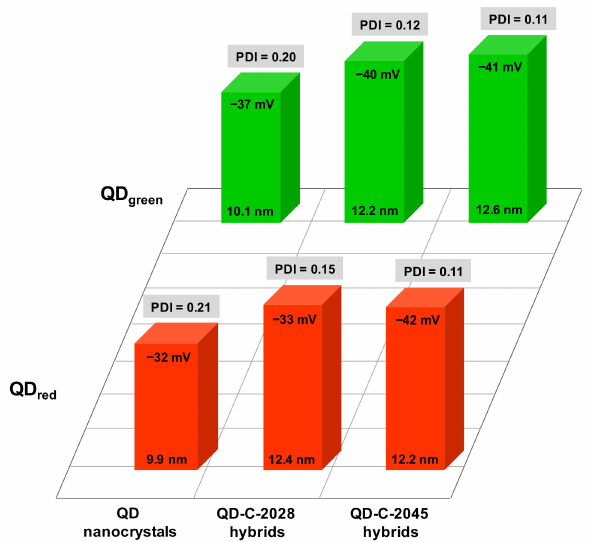
Figure 1. Mean size, polydispersity index (PDI), and zeta potential of quantum dot (QD) nanocrystals, QD − UA (unsymmetrical bisacridine derivatives) hybrids dispersed in PBS buffer based on dynamic light scattering (DLS) studies ( n = 5).